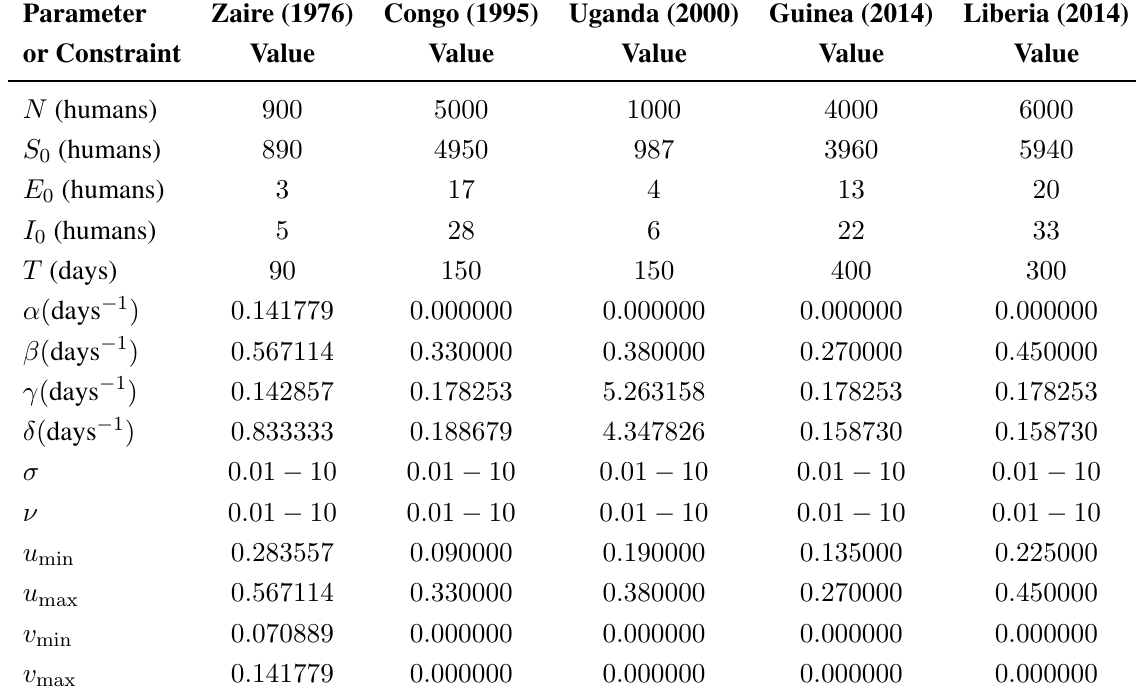
Table 1. Values for parameters, initial conditions for system (1), and control constraints (4).